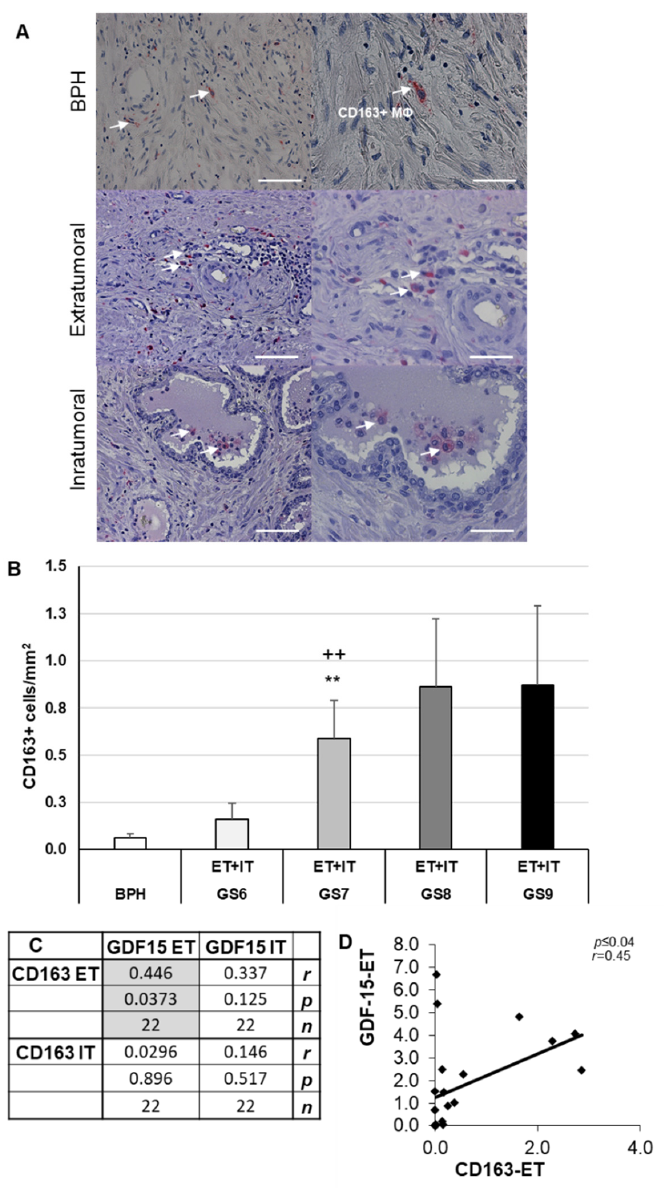
Figure 4. CD163+ M Φ IHC of human BPH and PCa. ( A ) Representative images of BPH and extratumoral [ET] or intratumoral [IT] PCa regions of CD163+ cells; CD163+ M Φ are marked with white arrows. ( B ) Density of CD163+ M Φ in BPH and PCa with different Gleason scores (GS). ( C , D ) Pearson’s correlation coefficient, a significant correlation was marked with gray. The data show means + SEM; significance: ** p ≤ 0.01 vs. BPH; ++ p ≤ 0.01 vs. GS6. Scale bars: left column 200 µm, right column 100 µm. Pearson product moment correlation between ET and IT of CD163+ and GDF-15+ ( C , D ). Correlation coefficient ( r ), p- value ( p ) and the number of samples ( n ).